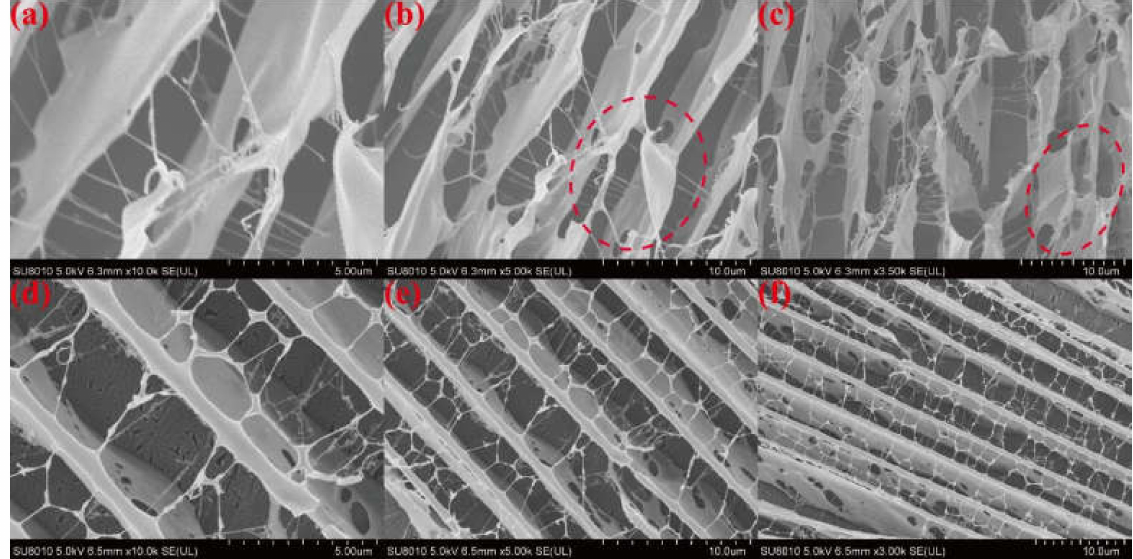
Figure 7. Cryo-SEM images of polymer solutions with and without nano-SiO 2 : polymer solution containing 1 wt% nano-SiO 2 : ( a ) × 10.0 k, ( b ) × 5.00 k, and ( c ) × 3.50 k; polymer solution without nano-SiO 2 : ( d ) × 10.0 k, ( e ) × 5.00 k, and ( f ) × 3.00